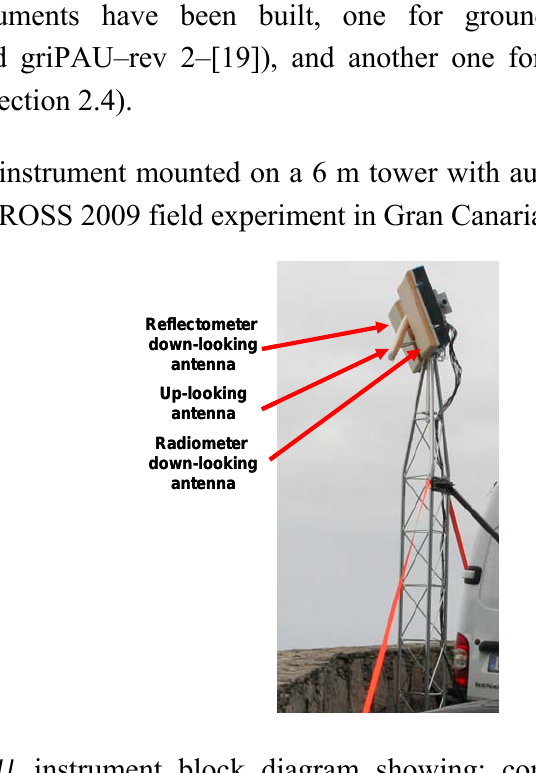
Figure 10. griPAU instrument block diagram showing: commercial GPS receiver to provide Doppler estimates, up-looking receiving element to provide delay estimates (every 5 ms), and down-looking receiving element (with 7 LHCP hexagonal patch array) to collect the reflected signal. The whole system is embedded in a Xilinx Virtex-4 FPGA and has serial USB